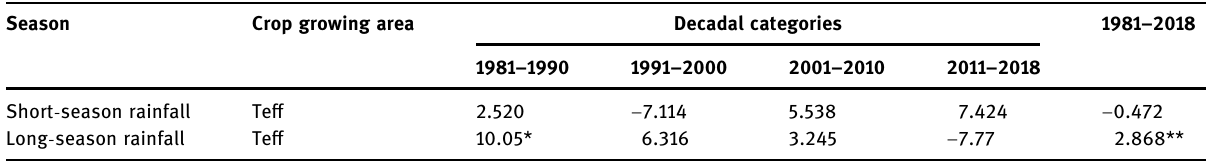
Table 2: Decadal trend of seasonal rainfall data in Te ff growing areas ( 1981 – 2018 )